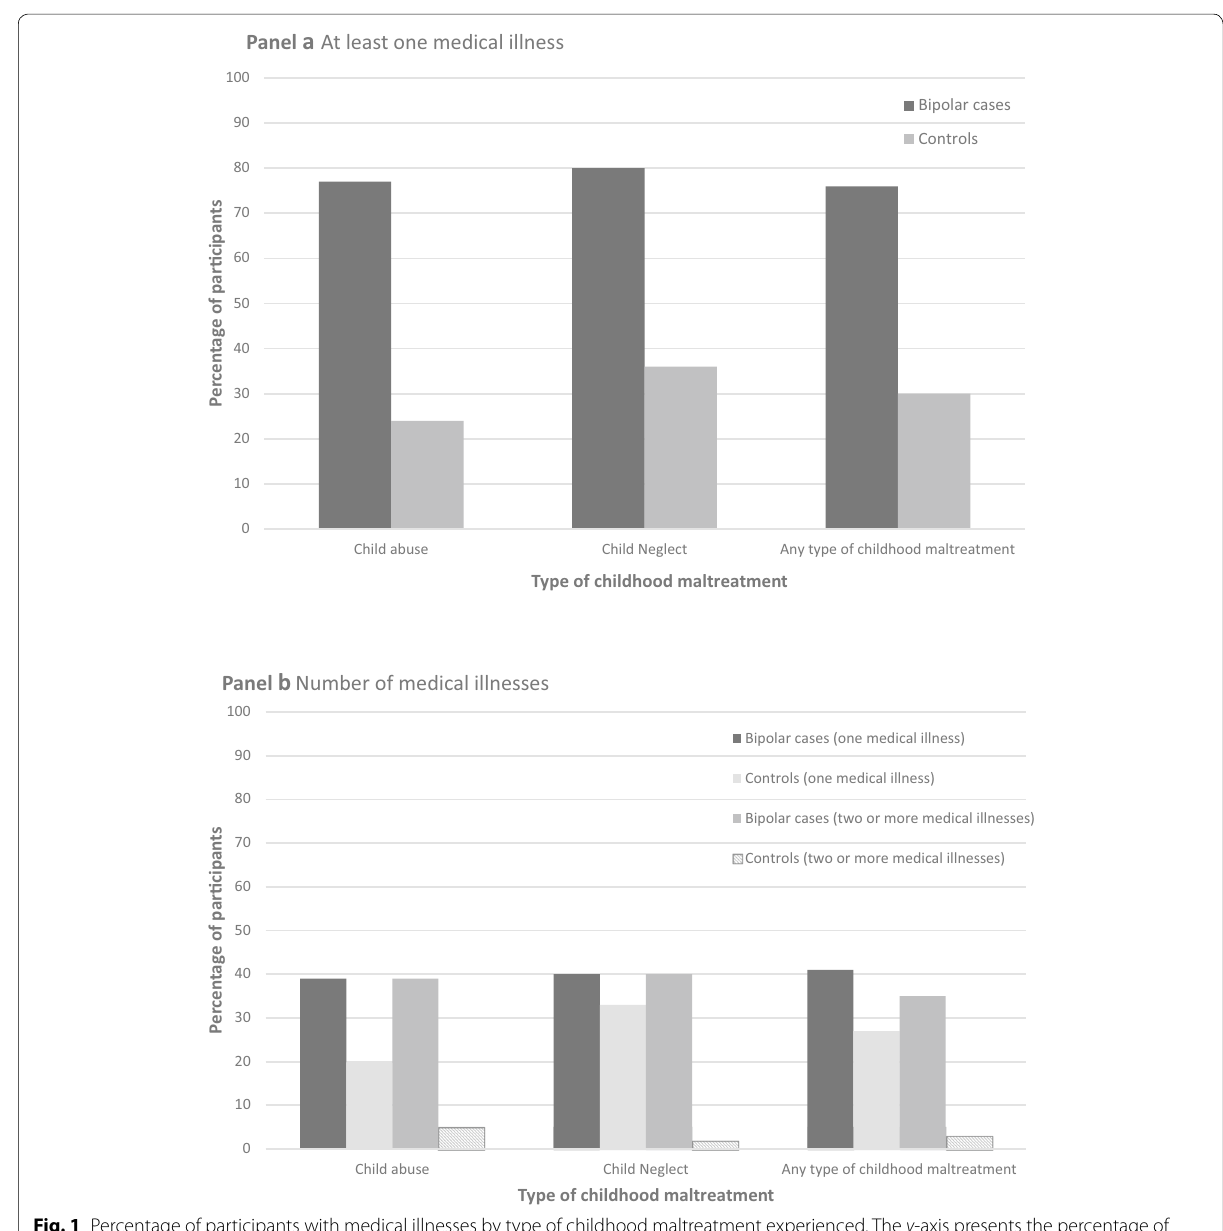
Fig. 1 Percentage of participants with medical illnesses by type of childhood maltreatment experienced. The y ‑axis presents the percentage of participants with medical illnesses by the different types of childhood maltreatment groups (child abuse, child neglect and any type of childhood maltreatment) for bipolar cases and controls. a The diagnosis of at least one medical illness and b the number of medical illnesses (one and two or